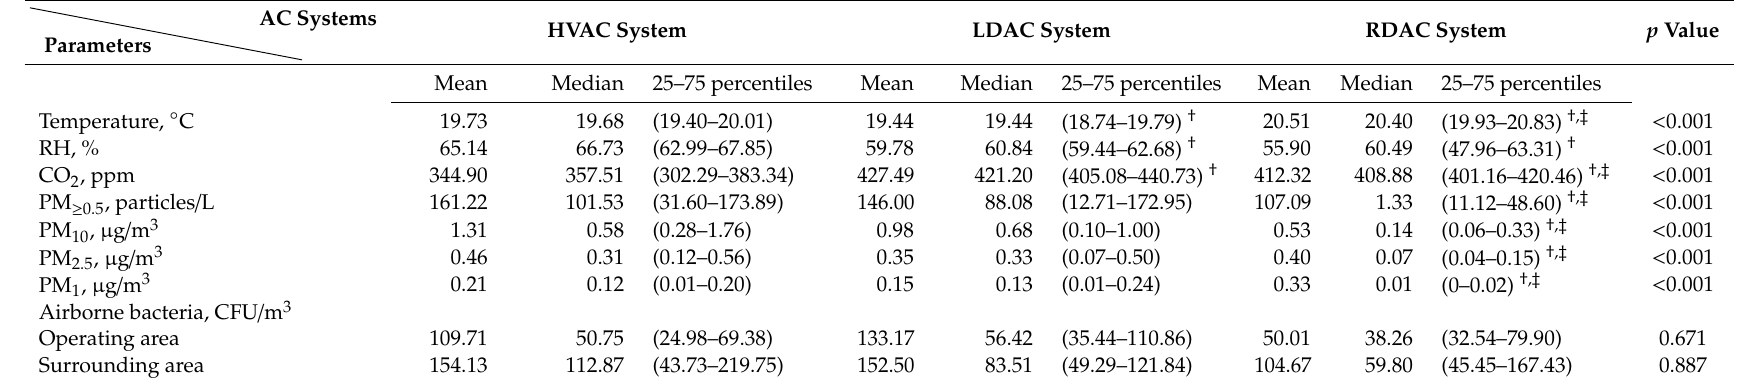
Table 1. Indoor thermal–hygrometric conditions and air quality of the operating rooms with di ff erent dehumidification air conditioning